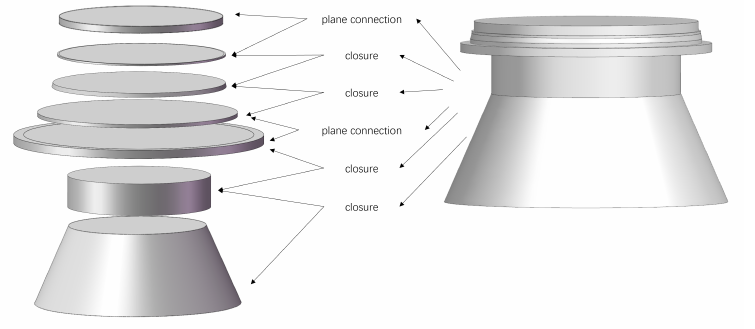
Figure 10. The feature recombination constraints determined by the topological relationship of the CAD model.